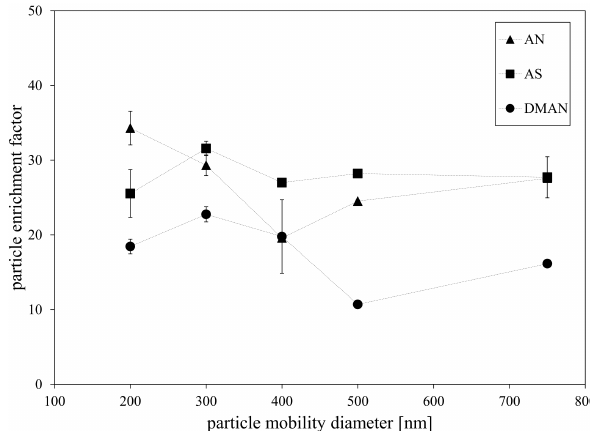
Figure 2. Transmission efficiency of the GPD for size-selected par- ticles generated from ammonium nitrate (AN), ammonium sulfate (AS), glutaric acid (GA) and methyl glyoxal (MG).